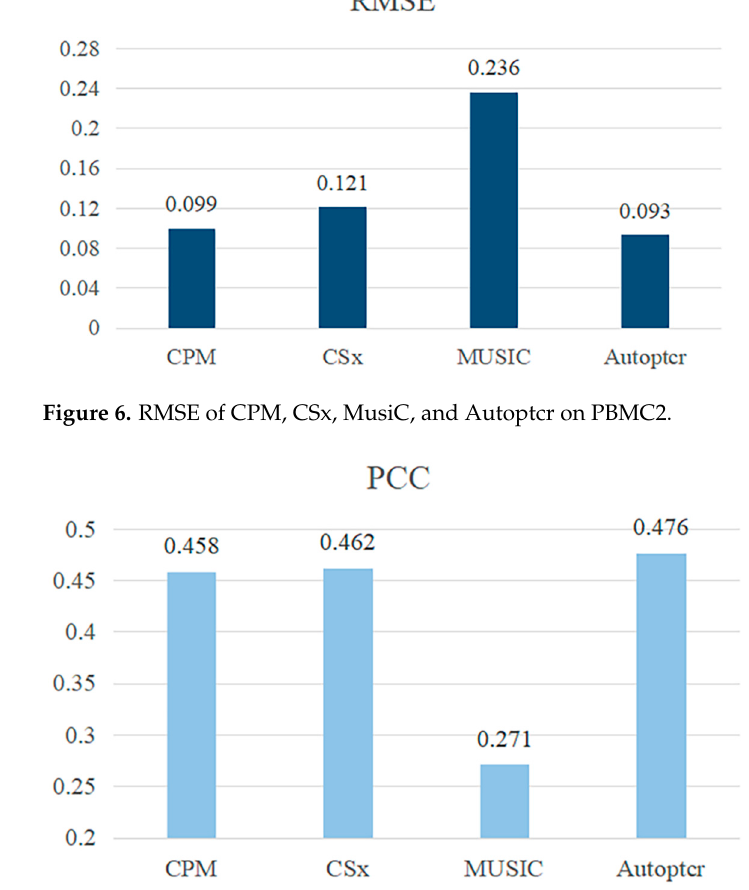
Figure 8. LCC of CPM, CSx, MusiC, and Autoptcr on PBMC2.